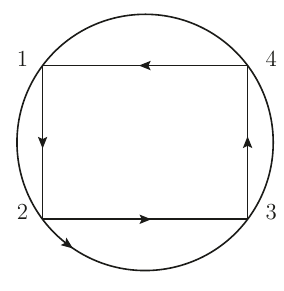
Figure 3 . The overall sign + under the new